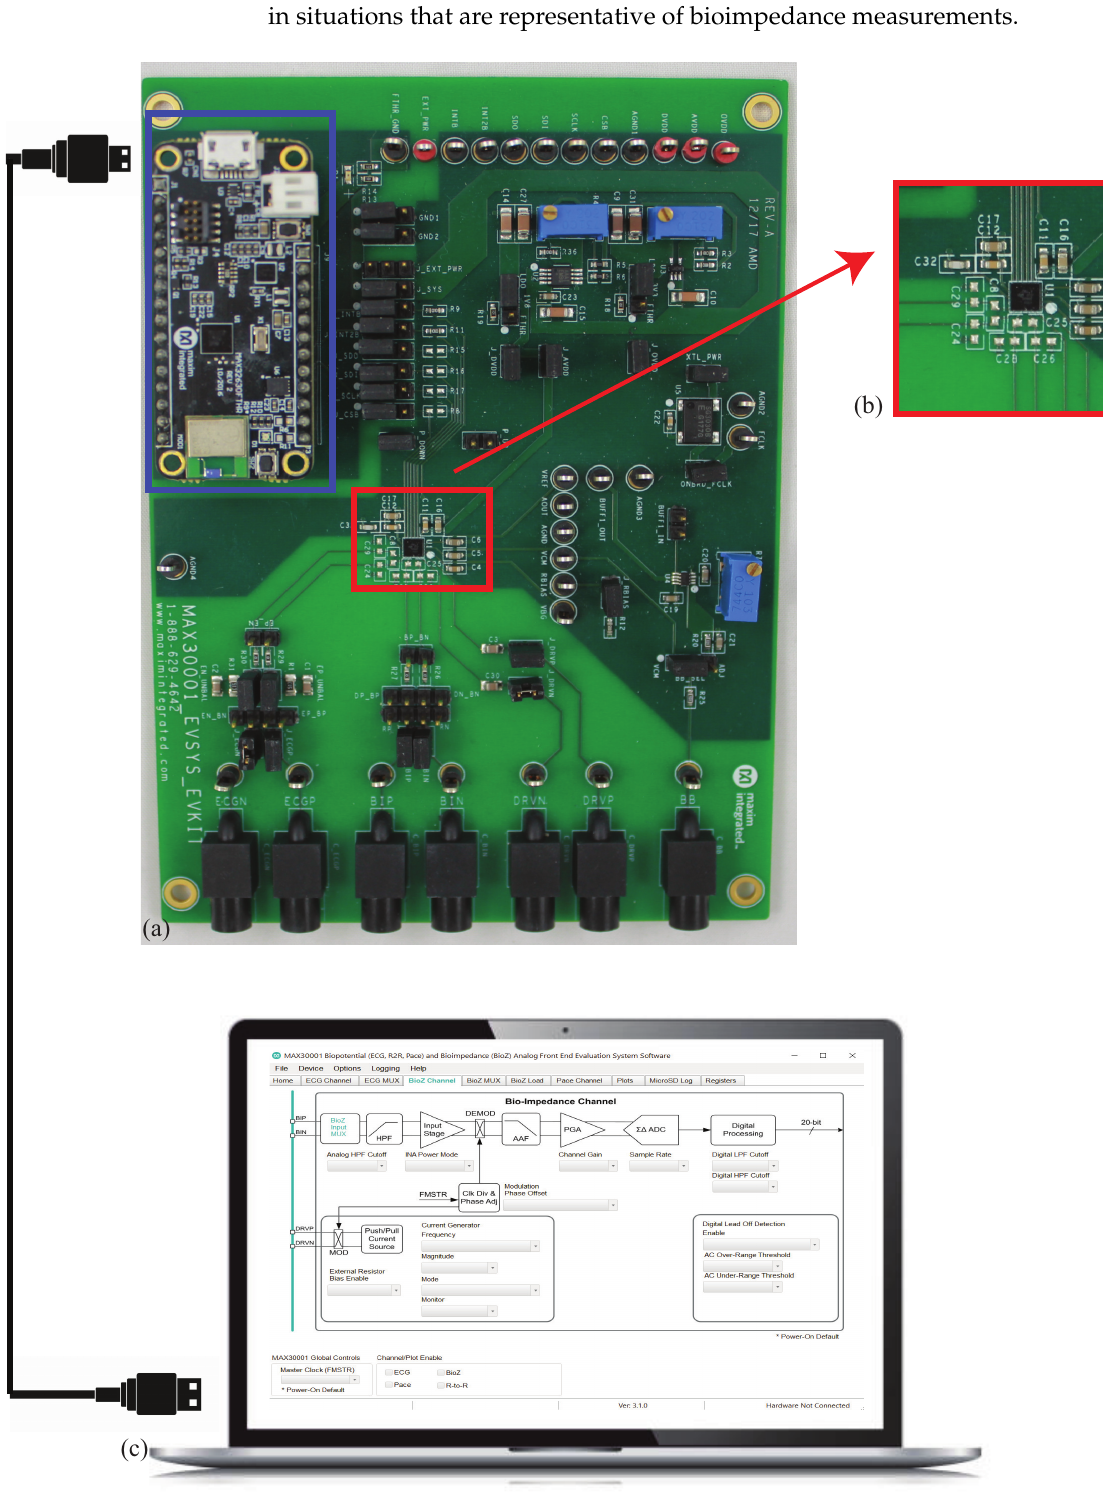
Figure 3. ( a ) MAX3000x development kit for control of ( b ) MAX30001 IC and peripheral circuitry ( c ) MAX3000x support software on a connected computer to control the bioimpedance channel